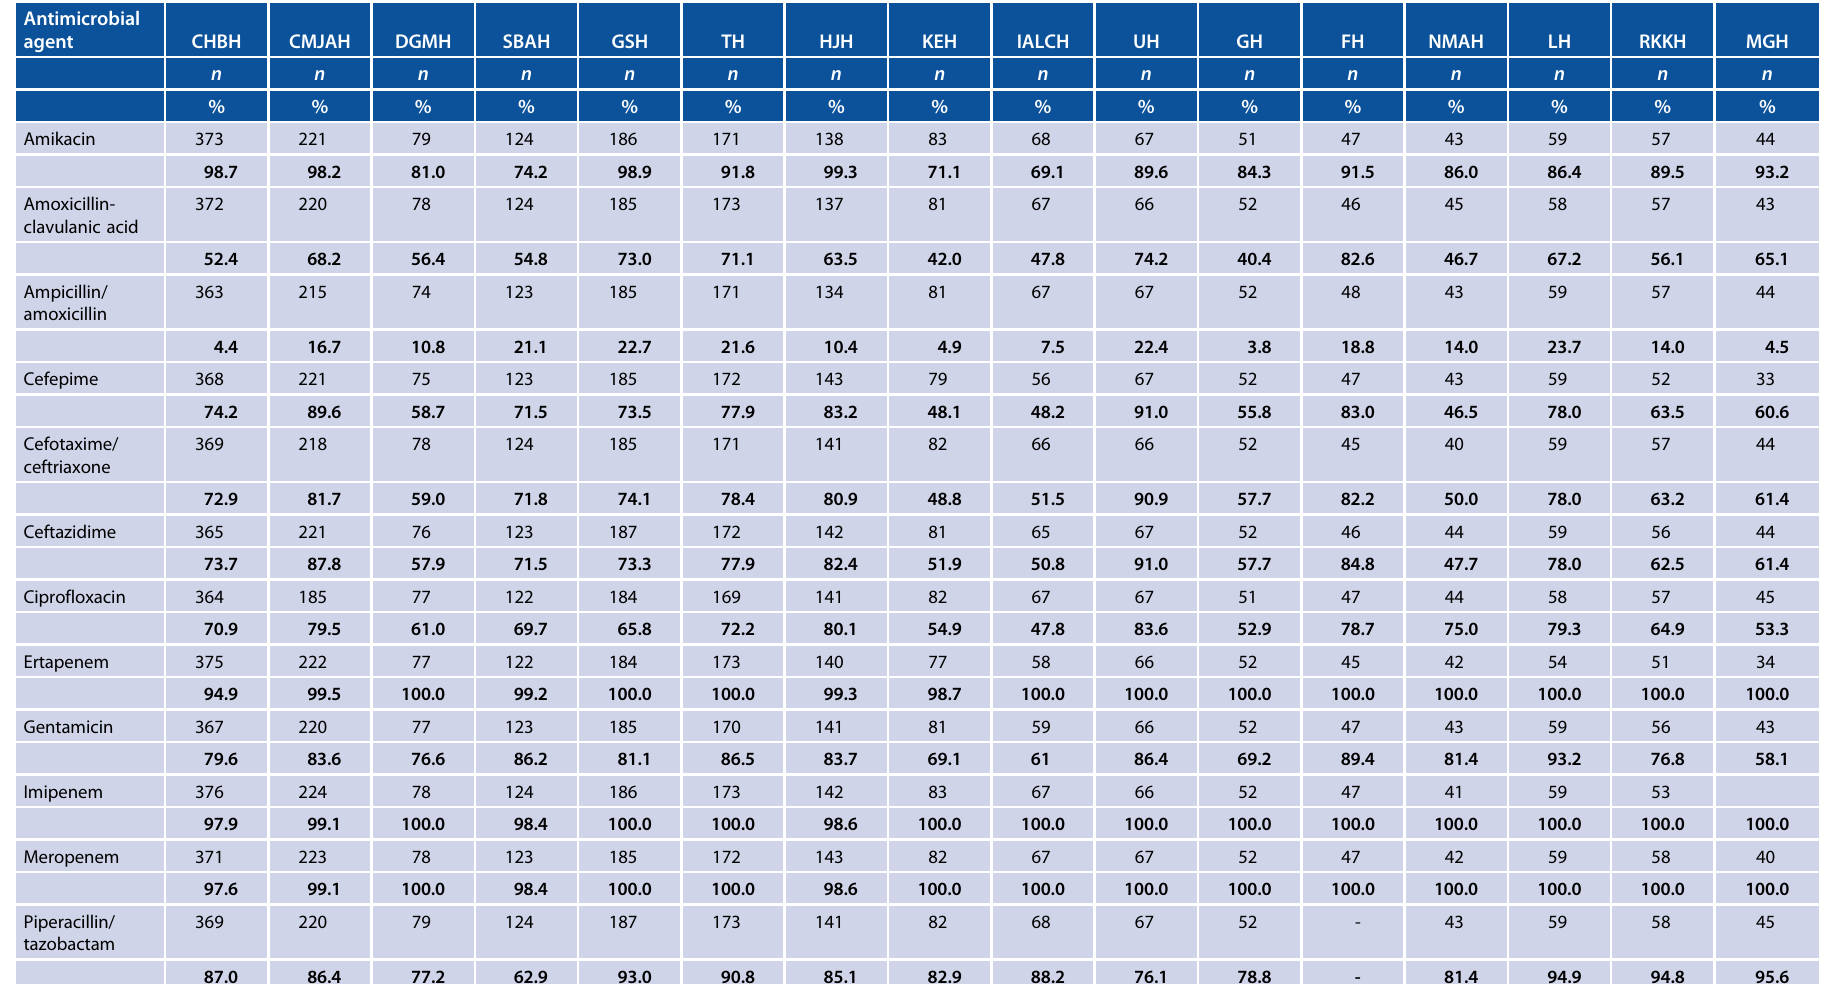
Table 5: Number and percentage of susceptible Escherichia coli isolates per antimicrobial agent from 16 sentinel hospitals across South Africa, January 1, 2016 to December 31, 2016 Antimicrobial agent